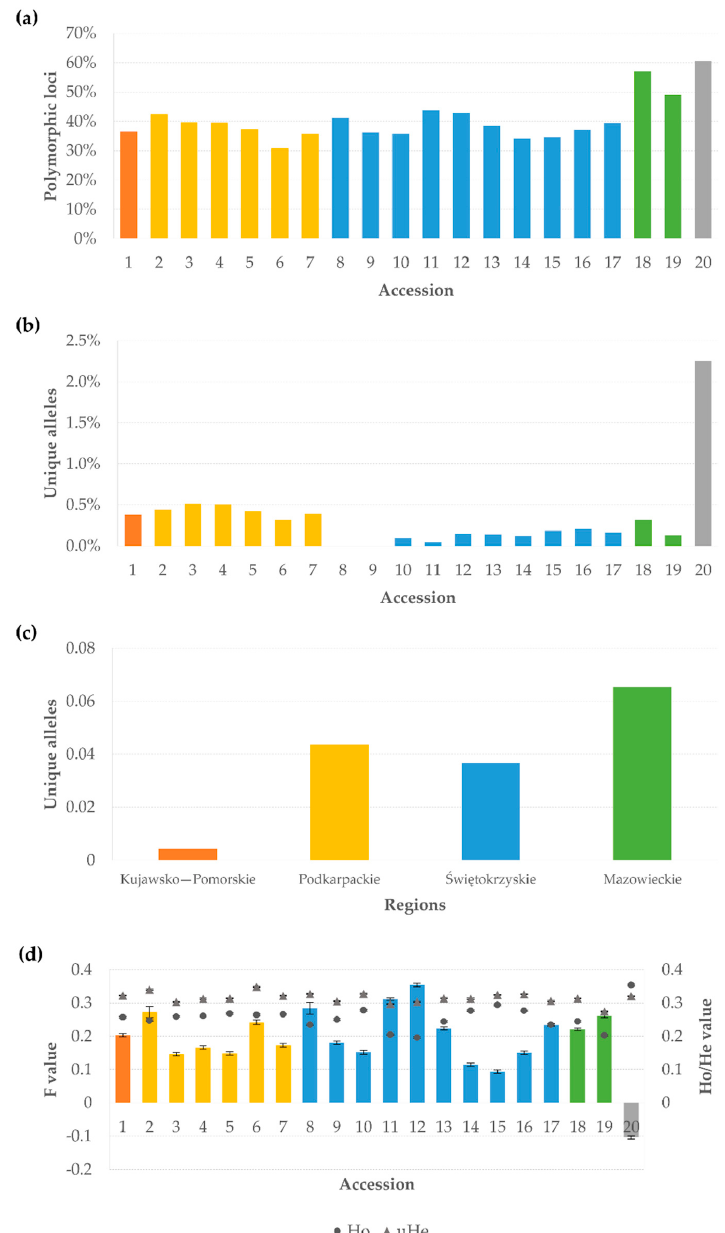
Figure 3. The results of the diversity analysis: ( a ) the percentage of polymorphic loci within the populations, ( b ) the contribution of unique alleles in the studied populations, ( c ) the percentage of